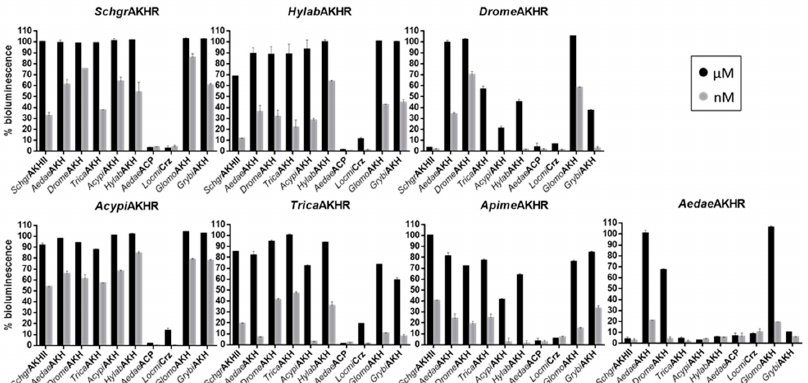
Figure 4. Receptor activation as assessed by a cell-based bioluminescent calcium assay: different insect peptides (indicated on the x -axis) belonging to the AKH/RPCH, ACP and Crz peptide families were